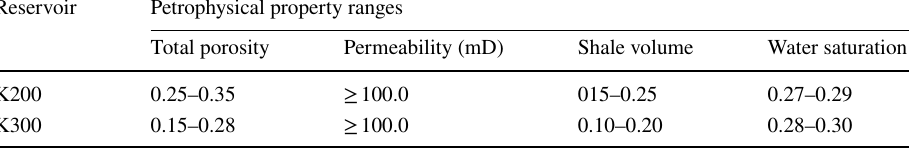
Table 2 Ranges of some petrophysical